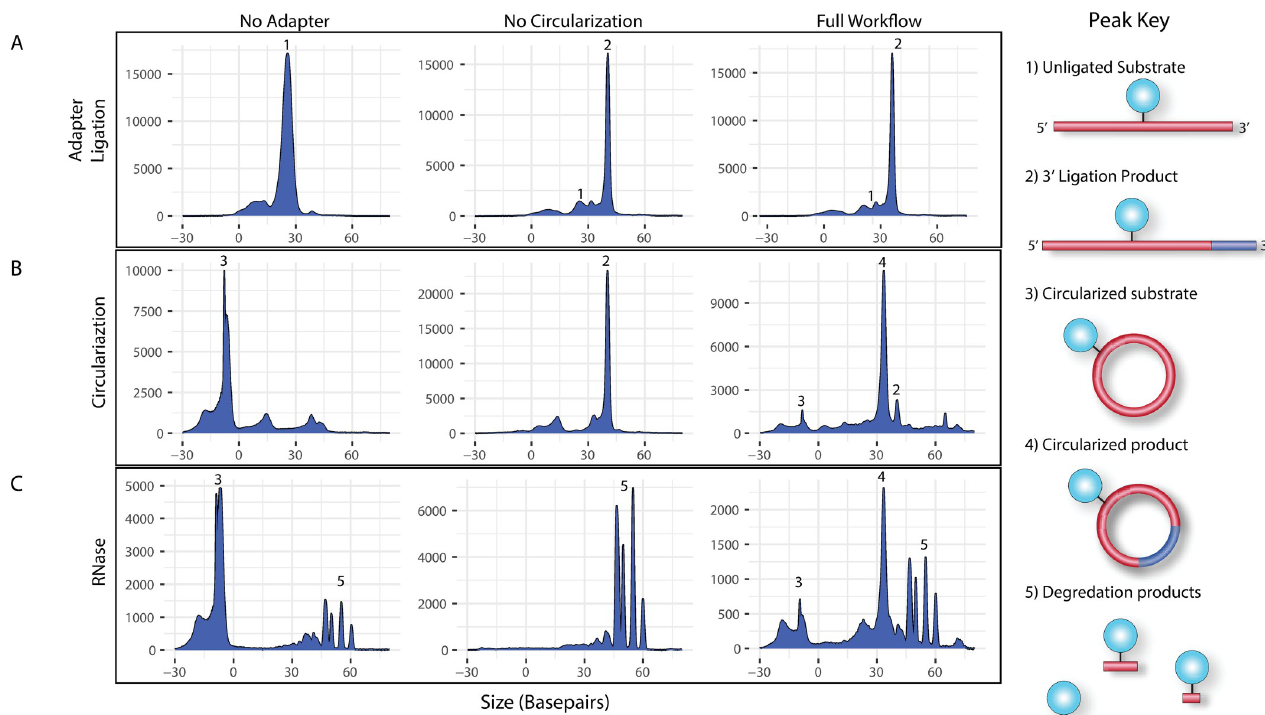
Fig 3. Quantification of small RNA adapter ligation step and circularization step in the SR-Cat-Seq workflow. Three sets of reactions were performed in parallel, with representative capillary electrophoresis traces shown. One set without the adapter (column 1, No Adapter), one set without the ligase (column 2, No Circularization) and one set including both (column 3, Full Workflow). (A) Reactions were sampled after adapter ligation. (B) Reactions were sampled after circularization. Note that the circular products migrate faster through the capillary, making their size appear smaller. (C) Reactions were sampled after exoribonuclease digestion. Note that free FAM dye or very short oligos migrate slower through the capillary due to low charge, which causes them to appear larger than their actual size.